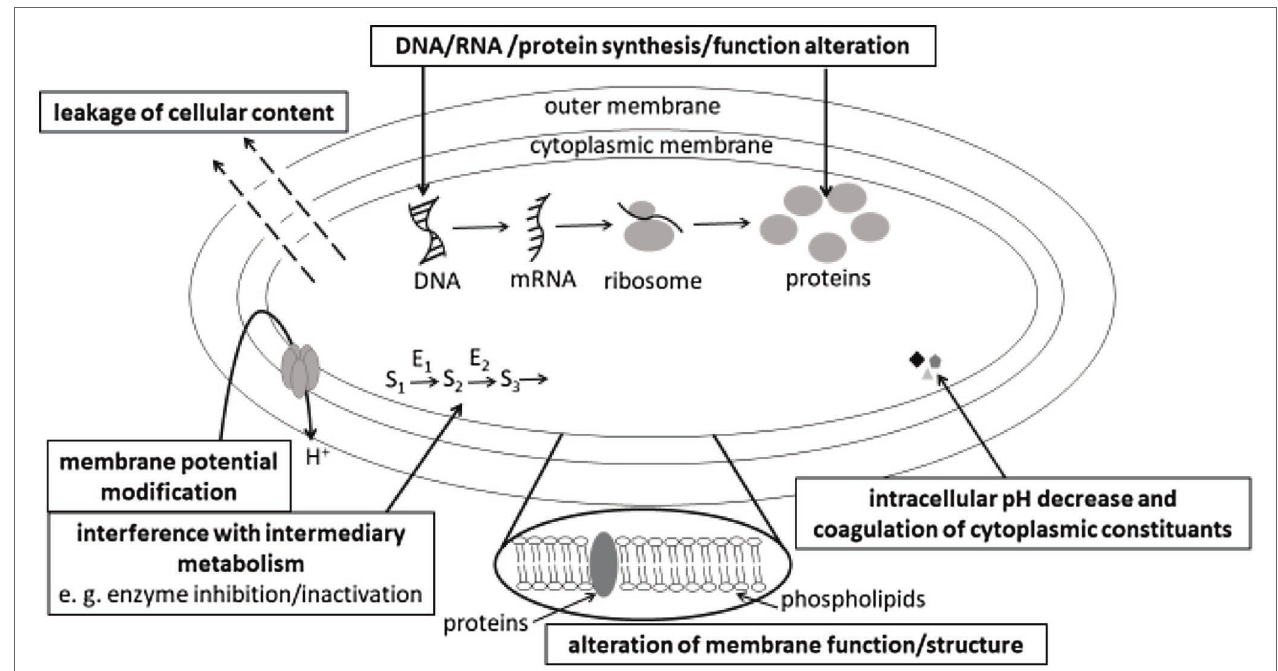
FIGURE 1 | Main mechanisms of antibacterial action of plant